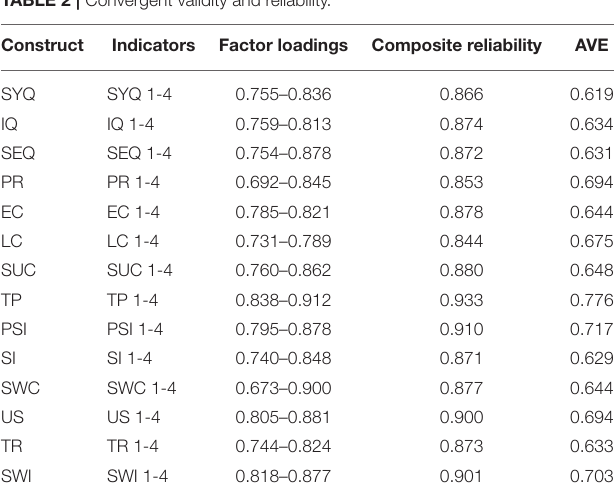
TABLE 2 | Convergent validity and